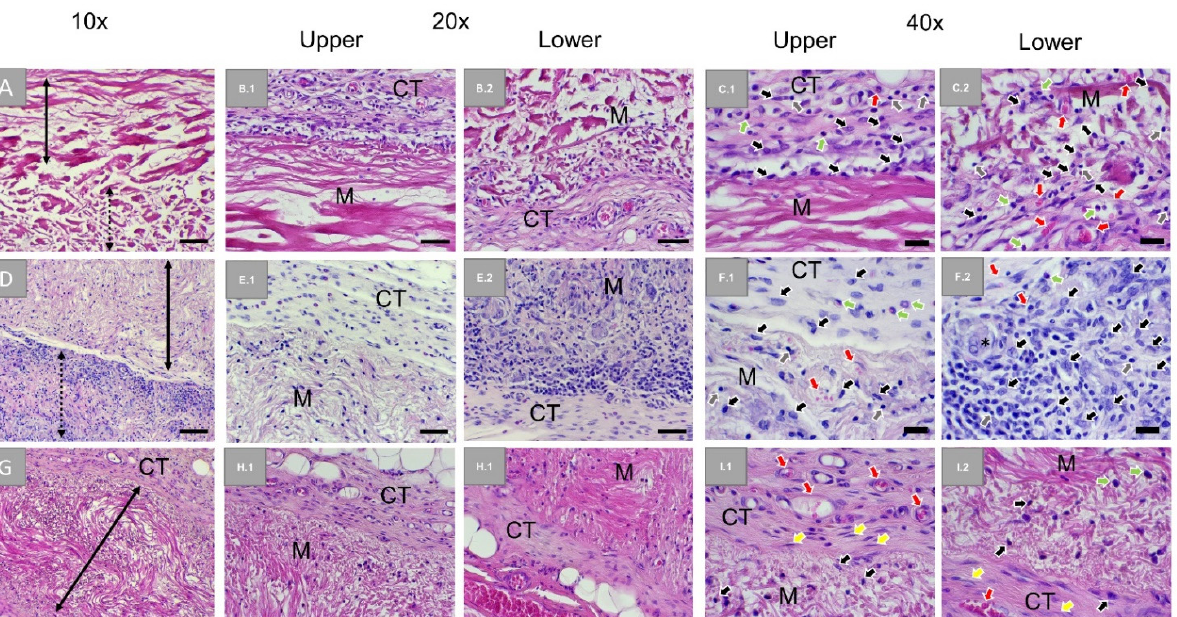
membrane (Ossix ® Plus) at three time points: 10 days (first row: ( A – C )), 30 days (second row: ( D – F )), and 60 days (third row: ( G – I )). Stretched black arrow: compact layer of the membrane and M: membrane, CT: connective tissue, black arrows: macrophages, red arrows: blood vessels, green arrows: granulocytes, grey arrows: lymphocytes, yellow arrows: fibroblasts.